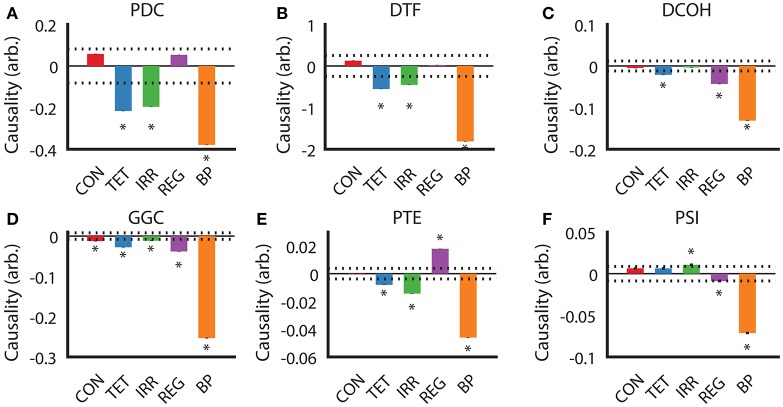
Determination of causal influences by directed connectivity estimators across experimental conditions. (A) PDC indicates under TET, IRR, and BP conditions, there is a statistically significant predominant SuM to HPC direction of causal influence. (B) DTF retuned the same pattern as PDC. (C) For DCOH, TET, REG, and BP all point to a statistically significant predominant SuM to HPC direction of causal influence. (D) All conditions have a statistically significant predominant SuM to HPC direction of causal influence assessed by GGC. (E) PTE revealed a predominant HPC to SuM causal influence in the REG condition, while TET, IRR, and BP causal influences are predominantly in the opposite direction. (F) PSI detected a marginal significant HPC to SuM causal influence in the IRR condition and an equally marginal influence in the opposite direction for REG. A predominant SuM to HPC causal influence was detected under PSI. Asterisks indicate mean values exceeding the 95% confidence interval drawn from a null distribution from trial-shuffled data. CON, control; TET, tetracaine; IRR, irregular; REG, regular at 7.7 Hz; BP, by-pass; HPC, hippocampus; SuM, supramammillary nucleus; PDC, partial directed coherence; DTF, directed transfer function; DCOH, directed coherence; GGC, Geweke-Granger causality; PTE, phase transfer function; PSI, phase slope index.